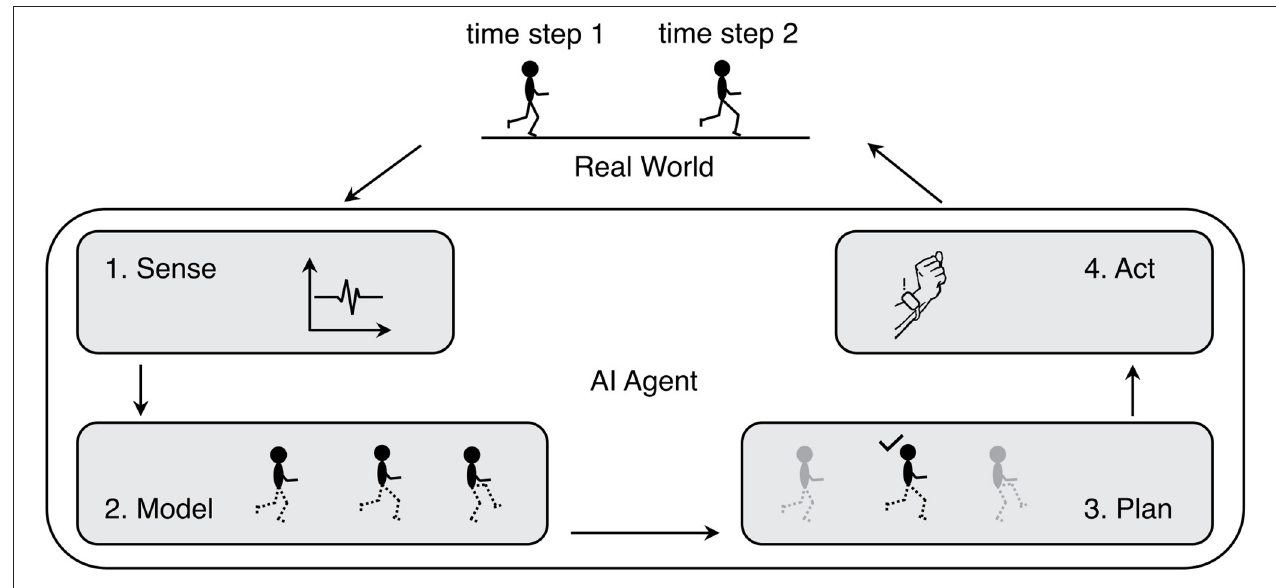
FIGURE 1 | Sense-Model-Plan-Act loop